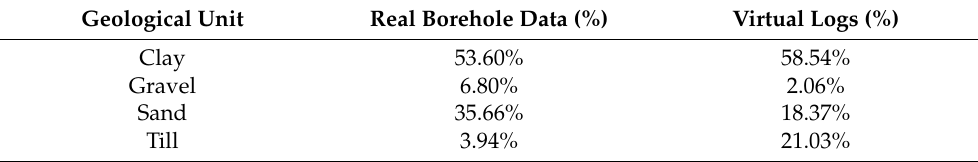
Table 1. Percentage of each soil type based on real and virtual borehole